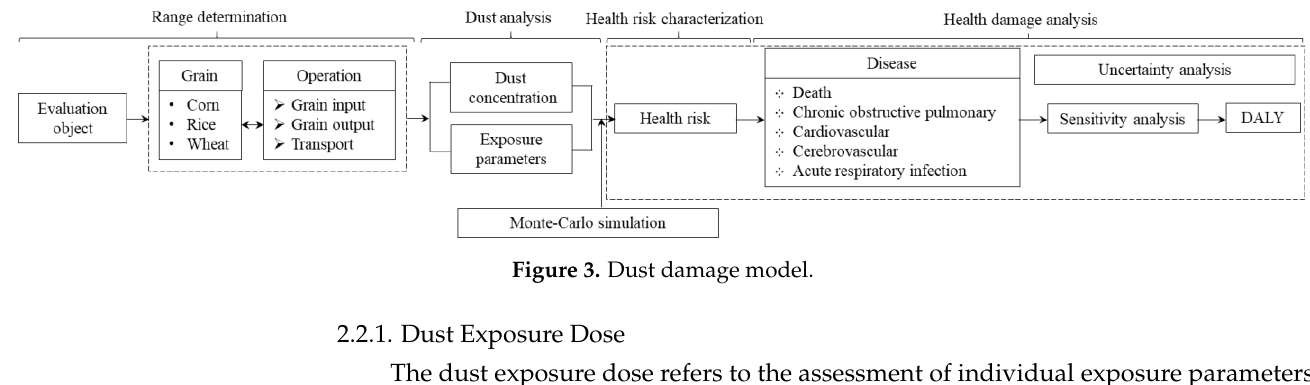
Figure 2. Dust concentration measuring instrument.